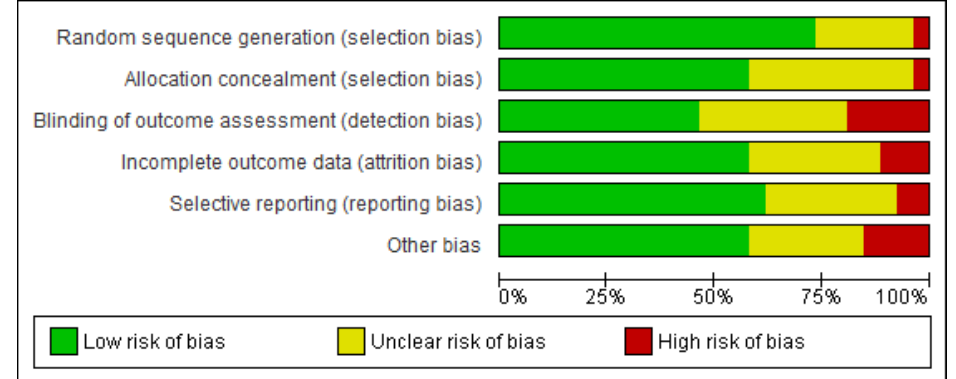
Figure 2. The risk of bias in included trials. Note: Review authors’ judgments about each risk of bias element are presented as percentages across all included trials.